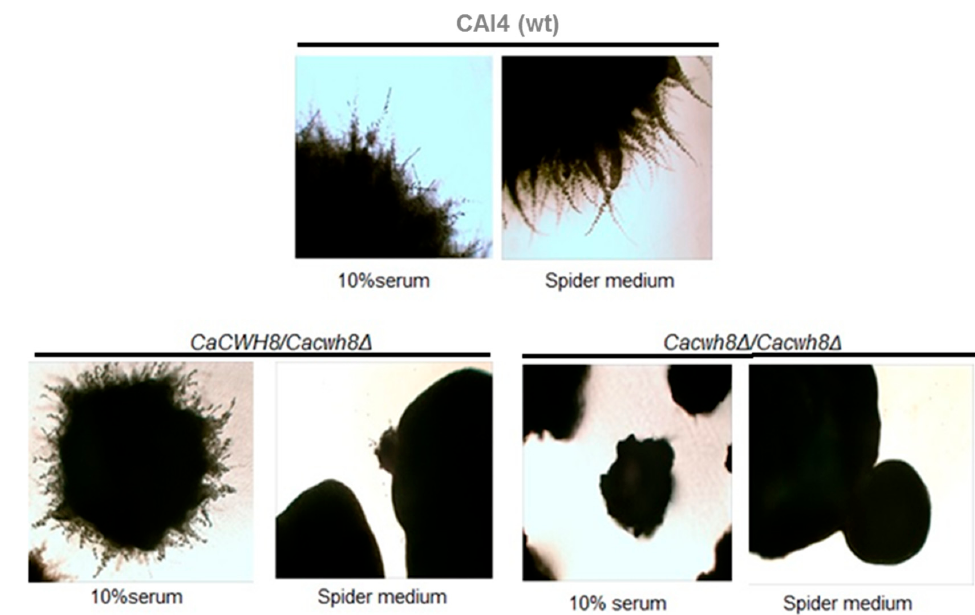
Figure 14. Hyphal growth of C. albicans wild-type strain CAI4 and the CaCWH8 mutants. Hyphae formation was induced for seven days at 30 °C on 10% serum, and on Spider medium and colonies were photographed under a light microscope with 40× magnification.